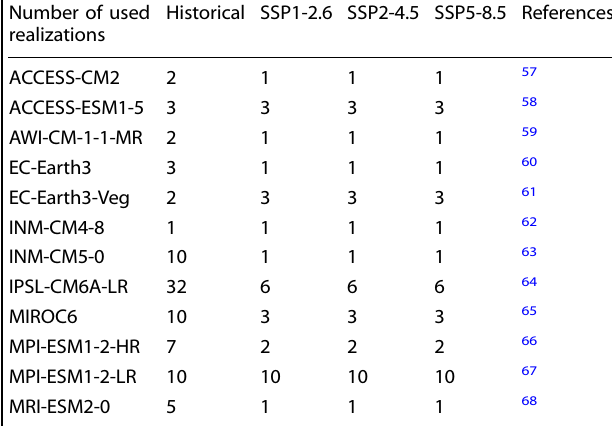
Table 1. Description of the used climate model ensemble for the historical run and three future